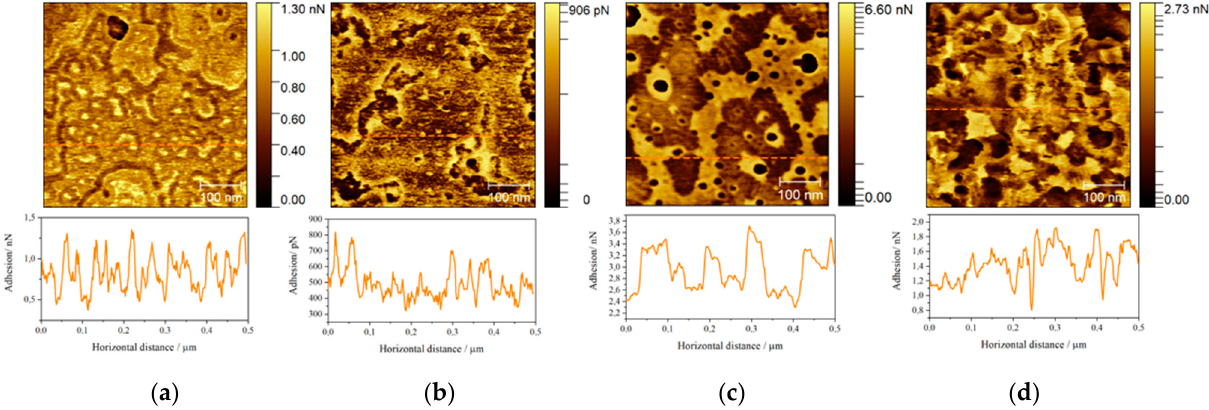
Figure 9. Upper panel: adhesion maps (500 × 500 nm 2 ) for ( a ) DOPC:Chol:SM 1:1:2, ( b ) DOPC:Chol:SM 1:2:1, ( c ) DOPC:Chol:SM 2:1:1 and ( d ) DOPC:Chol:SM 1:1:1 layers; Lower panel: vertical profiles corresponding to orange dashed lines in the above AFM images.